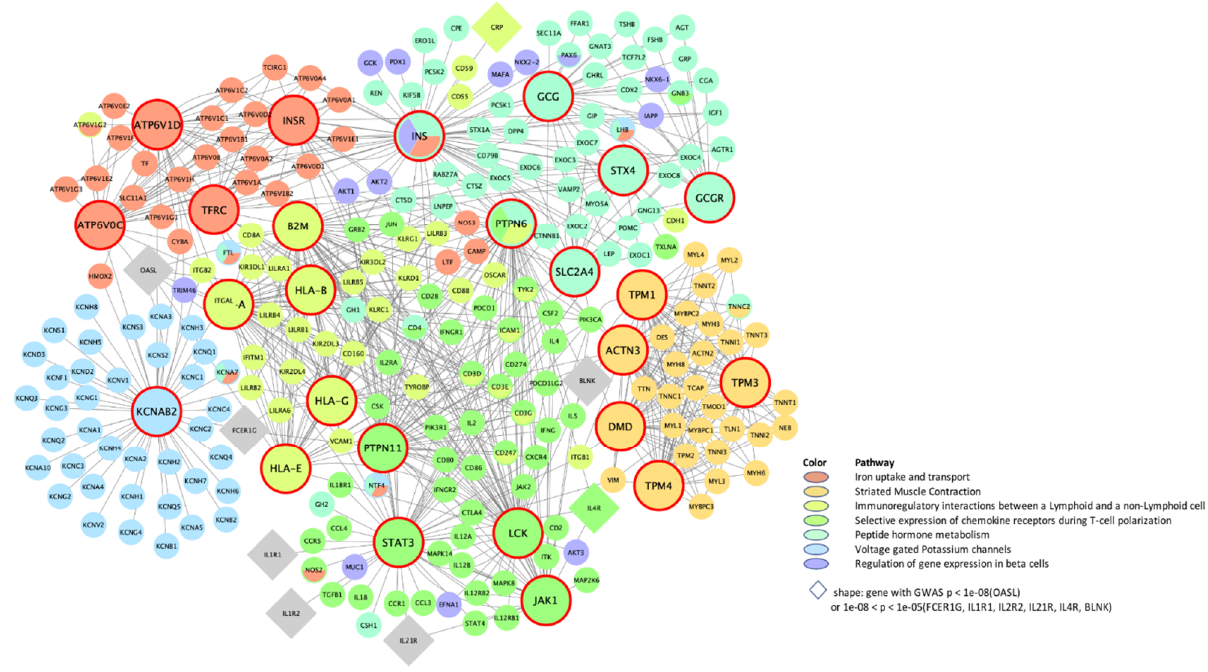
Figure 5. PPI-specific gene-regulatory networks of top KDs in meta-analysis of CRP and IL6 on 50-kb distance–based mapping. (CRP, C-reactive protein; IL6, interleukin-6; KD, key drivers; PPI, protein-to-protein interaction network. The bigger nodes with red outlines are the top KDs in the enriched pathway obtained from weighted KD analysis. The subnetworks of the KDs are indicated by different colors according to differences in their canonical functions.).